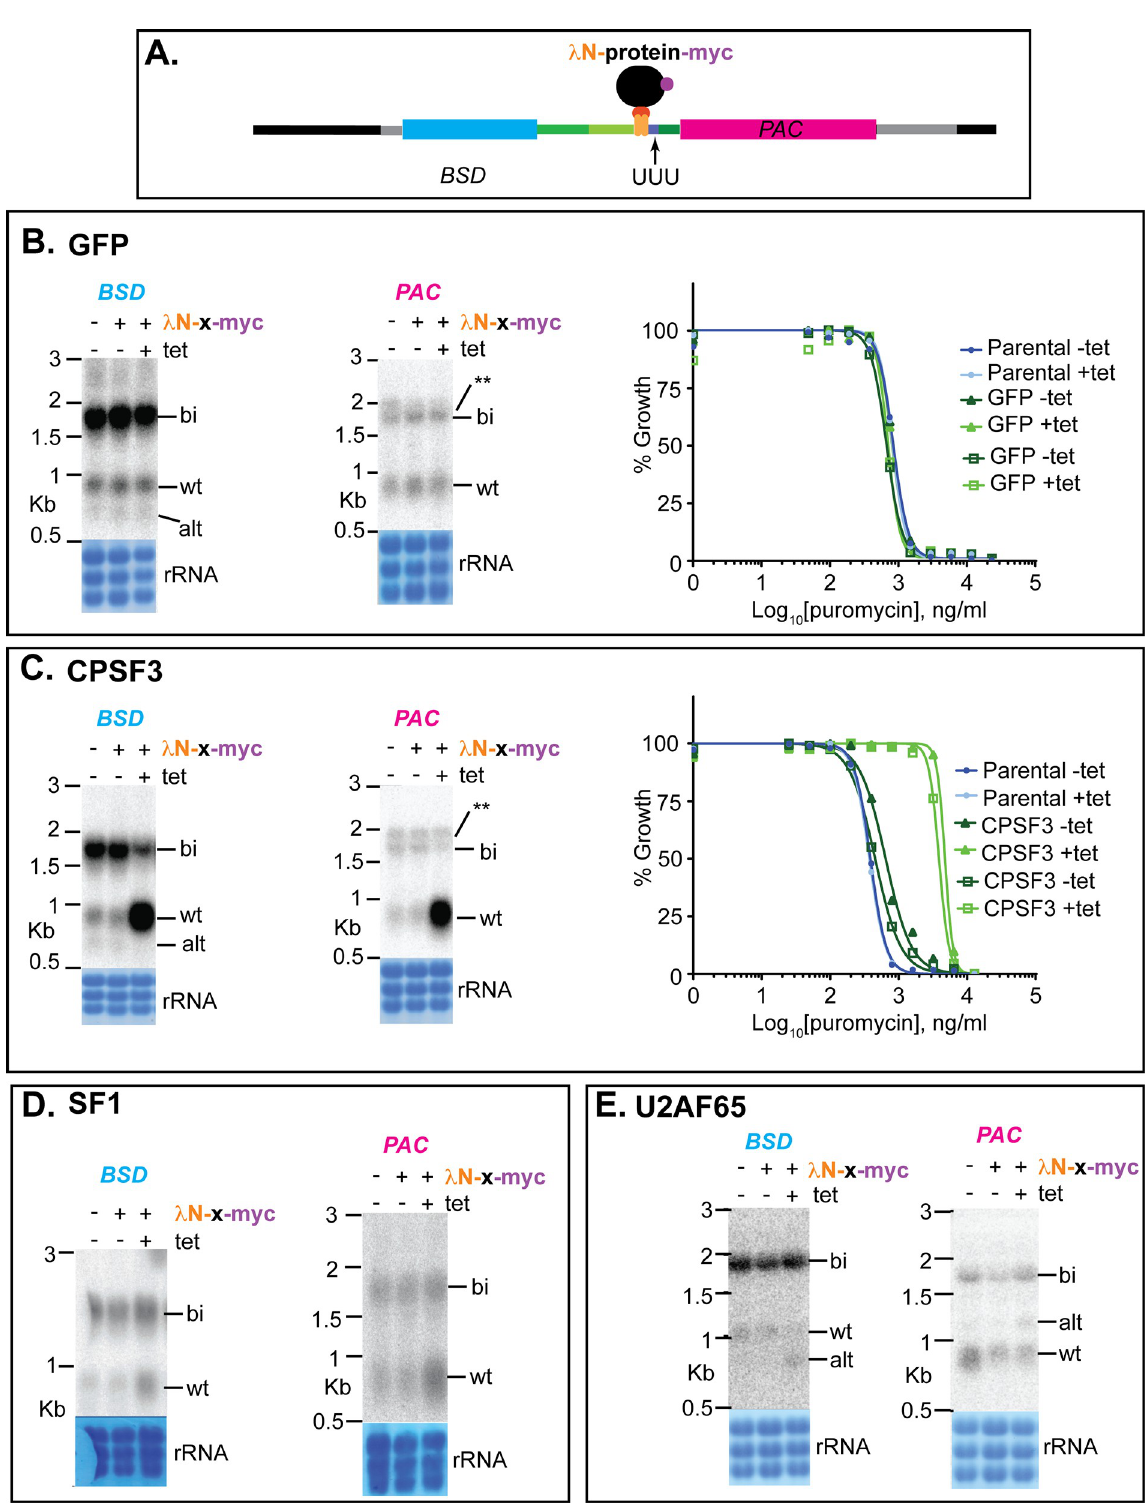
Fig 5. Effects of tethering GFP, CPSF3, SF1 or U2AF65 to the boxB-(U) 3 reporter. A. Cartoon showing the precursor before processing, with tethered protein. B. Tethering of lambdaN-GFP-myc. In this and all subsequent similar panels, a Northern blot is shown for cells with no inducible lambdaN protein, then one clone with and without tetracycline. Results for both BSD and PAC are illustrated, with the stained rRNA on the membrane below. The susceptibility of two different clones (with different symbols) to puromycin is shown on the right. Other labels